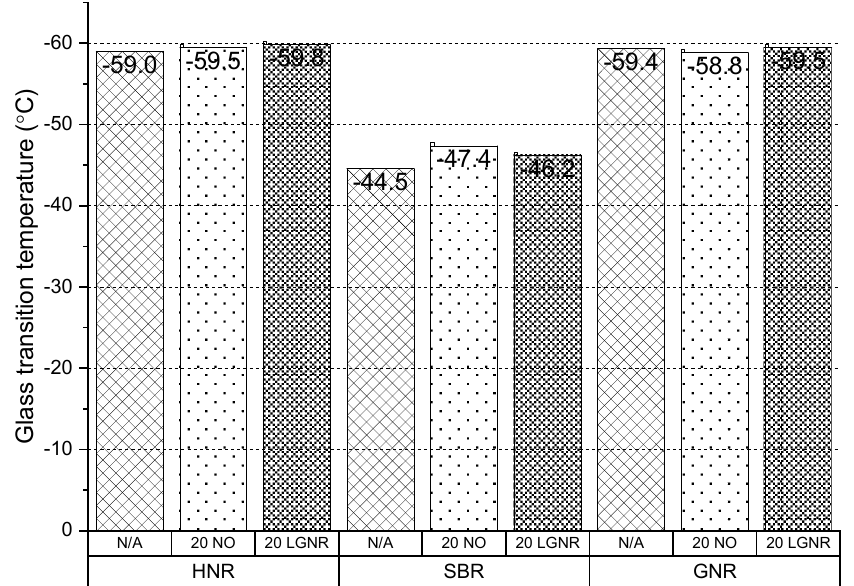
Figure 8. Glass transition temperatures of HNR, SBR and GNR composites made with or without processing aids. N/A: rubber compounds without processing aids; 20 NO: rubber compounds with 20 phr naphthenic oil; 20 LGNR: rubber compounds with 20 phr liquid guayule natural rubber. Table 3. Glass transition temperatures of naphthenic oil (NO) and liquid guayule natural rubber (LGNR). N/A: rubber compounds without processing aids; 20 NO: rubber compounds with 20 phr NO; 20 LGNR: rubber compounds with 20 phr LGNR.